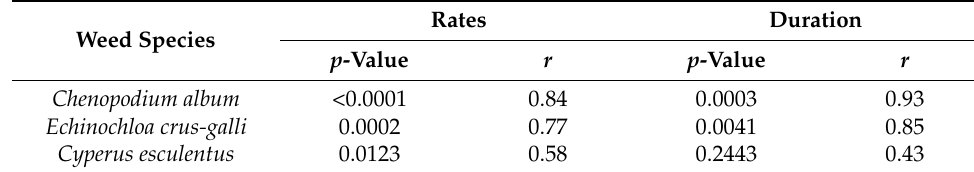
Table 8. Correlation between propagule mortality of various weed species and acetic + butyric acid concentrations and duration of exposure during experiments under laboratory conditions.